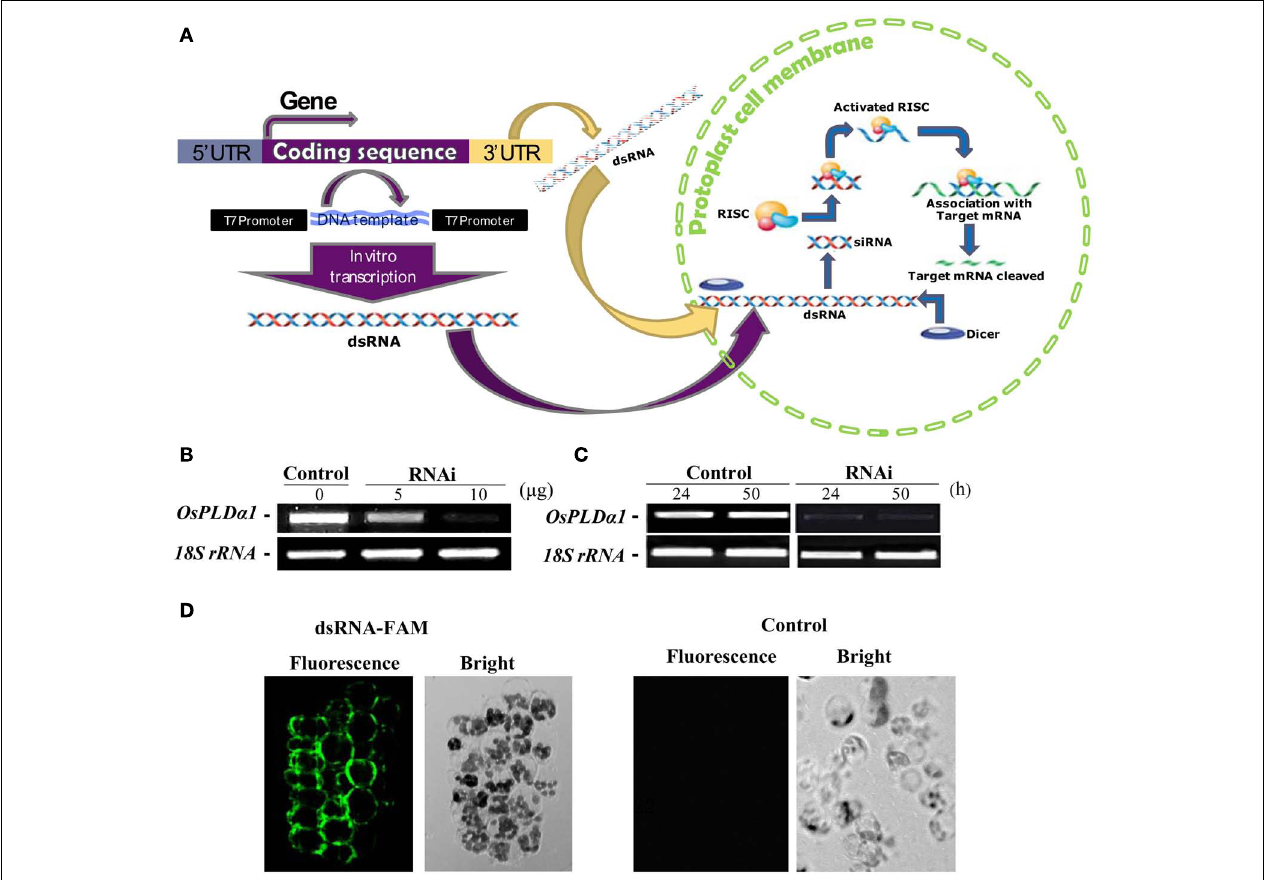
FIGURE 5 | Double-stranded RNA-induced RNA silencing in rice protoplasts. (A) Simple illustration of dsRNA-induced RNA silencing. RNAi silencing of OsPLD α 1 in rice protoplasts. Protoplasts were transfected with 0, 5, or 10 μ g of dsRNA against OsPLD α 1 (RNAi) or with